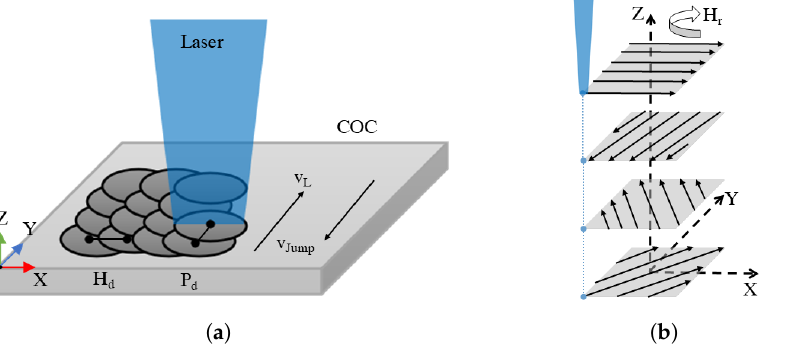
Figure 3. ( a ) Schematic representation of laser ablation with pulse spacing P d , hatch spacing H d , scan velocity v L , jump velocity v Jump . ( b ) Representation of the hatch rotation and dynamic refocusing.